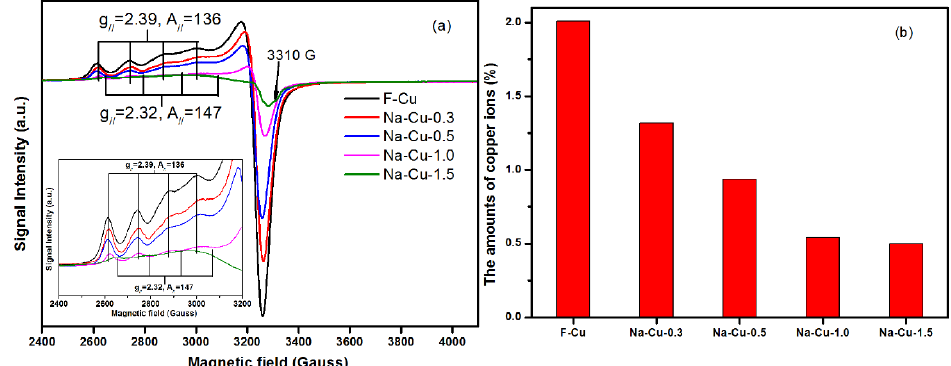
Figure 5. EPR spectra ( a ) and the quantitative results ( b ) of fresh and Na-impregnated catalysts.